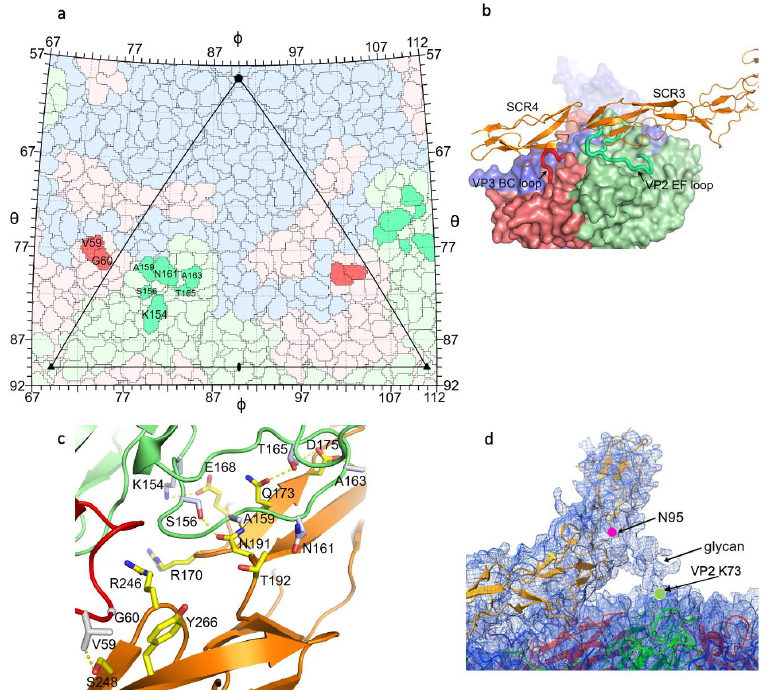
Figure 2. Interactions of E11 and DAF. ( a ) Roadmap [31] showing the residues of E11 involved in E11-DAF protein interactions. ( b ) SCRs 3 and 4 of DAF (orange), and the VP2 EF loop (green)and VP3 BC loop (red) of E11 are involved in E11-DAF interactions. The viral protomer is drawn as surface representation with the two loops involved in contacts with DAF shown as coils. VP1, 2 and 3 of E11 are colored in blue, green and red, respectively. ( c ) Binding residues at the E11-DAF interface (E11: VP2 green, VP3 red, DAF orange). Side chains of E11 are shown as grey sticks and those of DAF shown as yellow sticks; ( d ) Density showing contact between the Glycan attached to residue N95 of DAF (shown as a magenta circle) and residue K73 of VP2 (marked with a green circle).